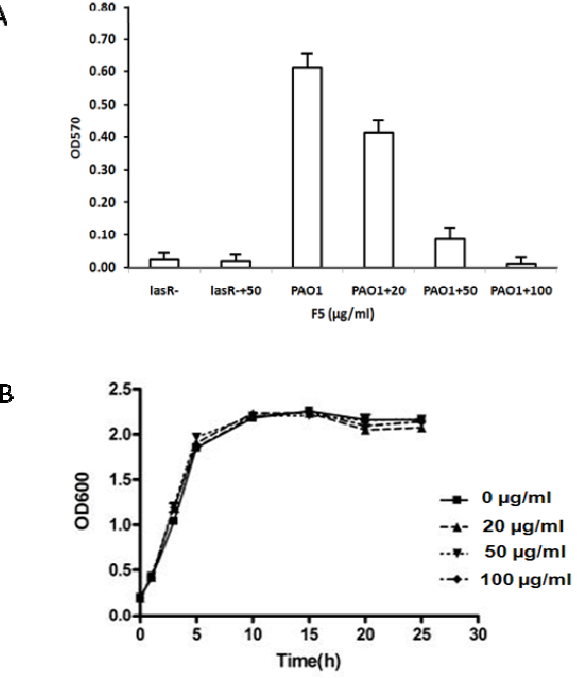
Figure 3. Bioassay testing effect of F5 on biofilm formation and growth. ( A ) Measurements of effects of F5 serial dilutions on biofilm formation in PAO1 and lasR − mutant. Blank control was set by addition of methanol, F5 at 0 µg/mL as CK (control), 20, 50, and 100 µg/mL, respectively; ( B ) Effect of F5 on planktonic growth of P. aeruginosa PAO1. Cells were grown in LB medium, in the presence of different concentrations of F5 at 0 µg/mL as control, 20, 50, 100 µg/mL, respectively. The data represent mean values of three independent